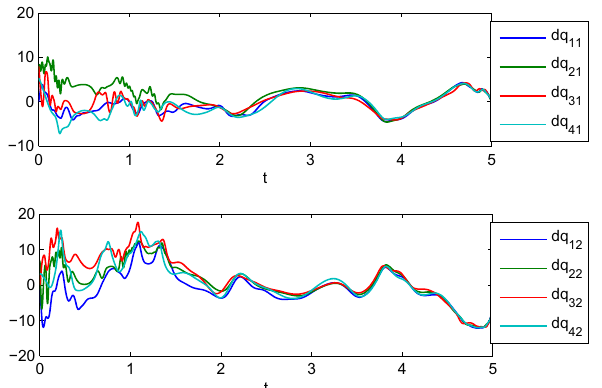
Figure 9. Dynamic coordinated motion for the generalized velocities, where dq i1 and dq i2 represent the 1st and 2nd components of generalized velocities of manipulators i ( i = 1, 2, 3, 4 ) .